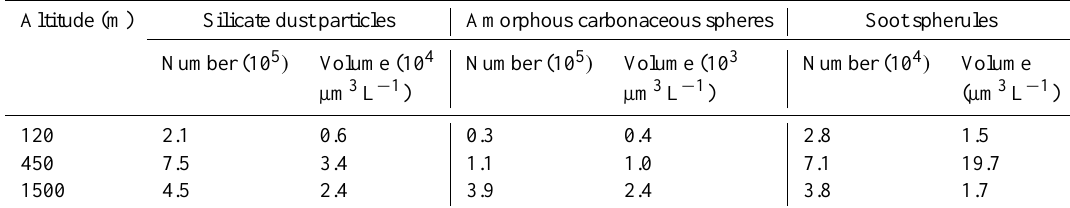
Table 3. Number and volume concentrations per standard liter of air of silicate dust particles, and amorphous carbon spheres from SEM observations at three altitudes. Using the relative concentration of brown carbon and graphitic soot spherules based on TEM observations, the number and volume concentrations of spherules are also